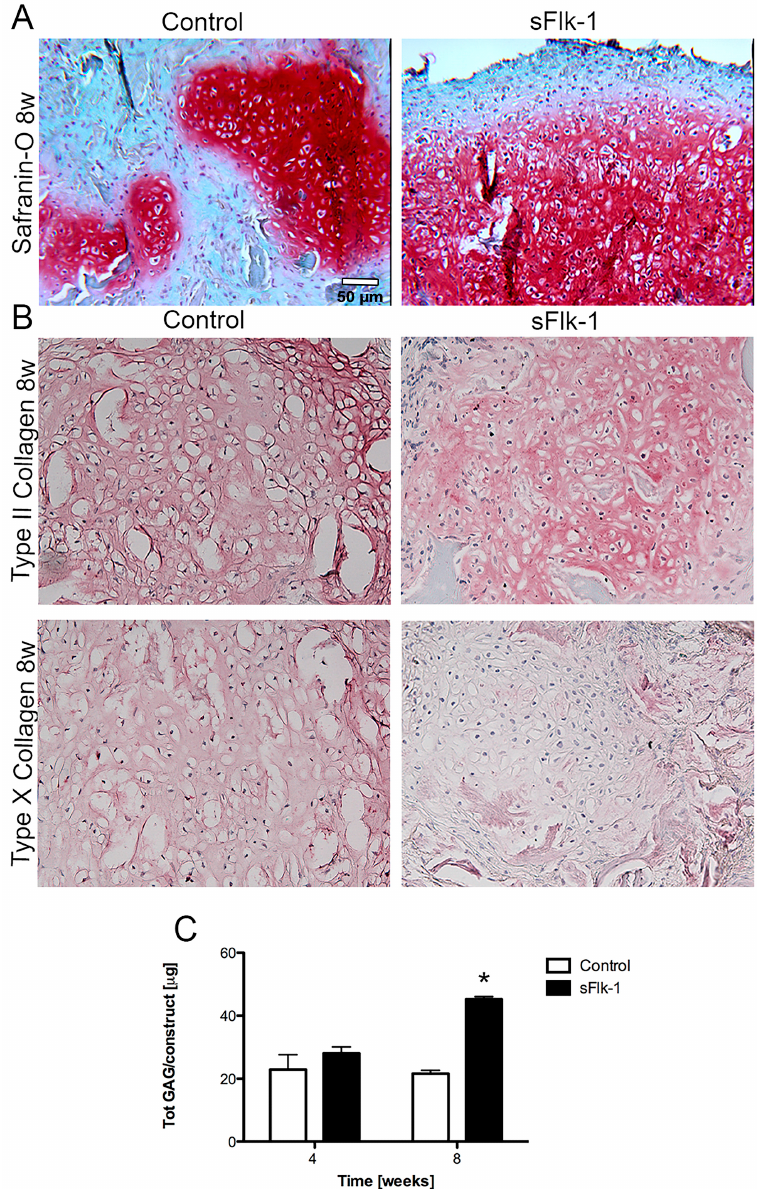
Figure 4. In vivo chondrogenesis of nasal chondrocytes—cell-based gene therapy approach. ( A ) Safranin-O staining for naïve (control) and sFlk-1-releasing NC after 8 weeks in vivo. ( B ) Types II and X collagen stainings for naïve and sFlk-1 NC at 8 weeks in vivo. ( C ) Total amount of GAG deposited in vivo at 4 and 8 weeks by naïve and sFlk-1 expressing NC (2 donors, n = 8). * p < 0.01. Scale bars = 50 µm.